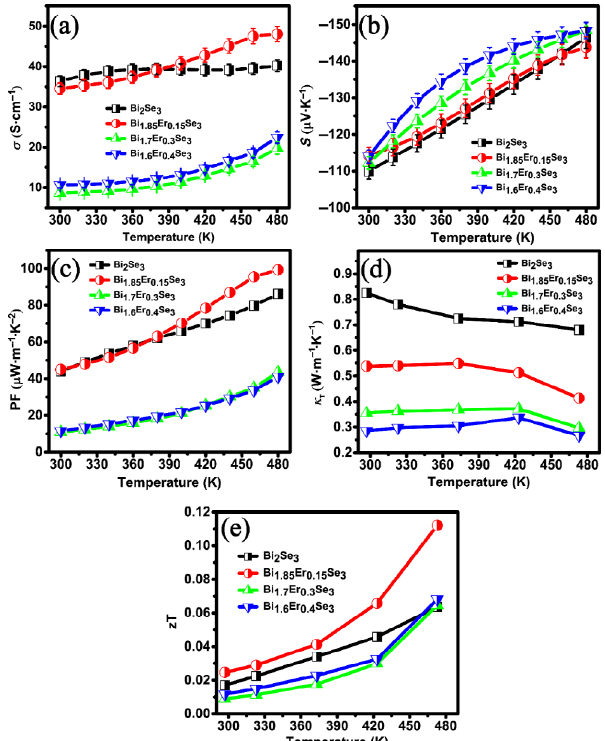
Figure 6 Temperature dependence of the (a) electrical conductivity, (b) Seebeck coefficient, (c) calculated power factor, (d) the total thermal conductivity, (e) the thermoelectric figure of merit of the Bi 2– x Er x Se 3 samples. Adapted with permission from Ref. [102], © Published by Elsevier B.V. 2020.